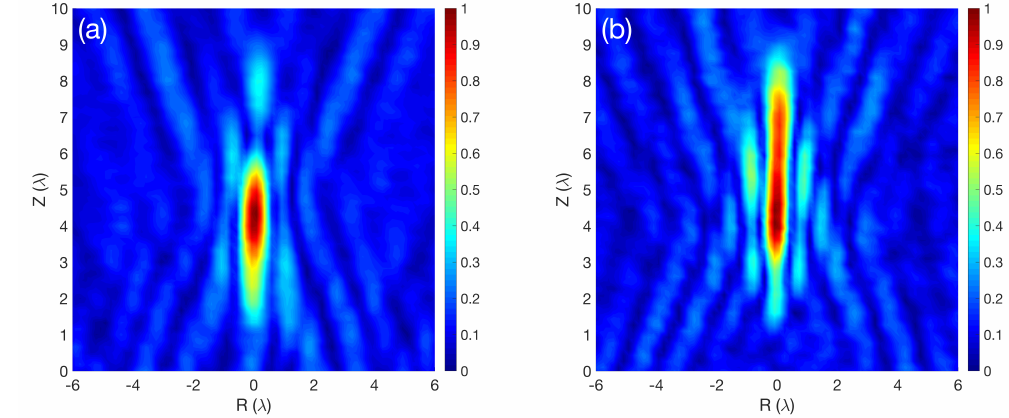
Figure 5. Experimental self-normalized intensity map results for the implemented lenses; where ( a ) corresponds to the experimental classical Soret Zone Plate (SZP) and ( b ) corresponds to the implemented Pupil masked Soret Zone Plate